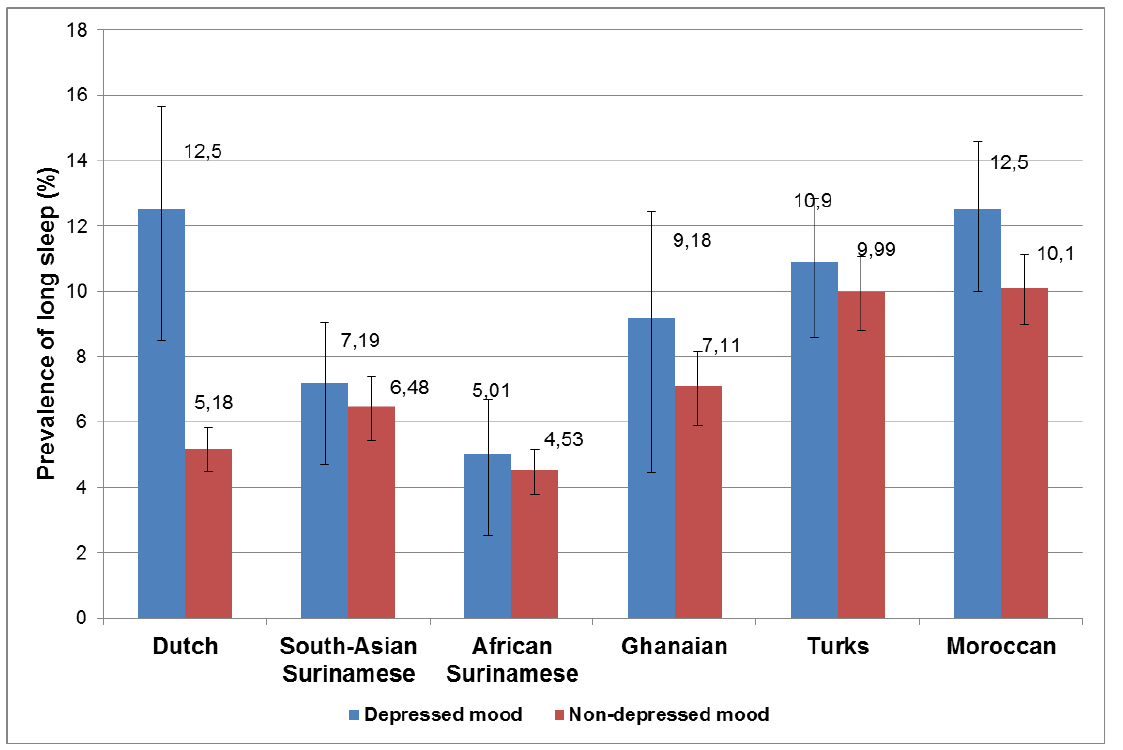
Figure 2. Association between depressed mood and long sleep duration among six ethnic groups living in